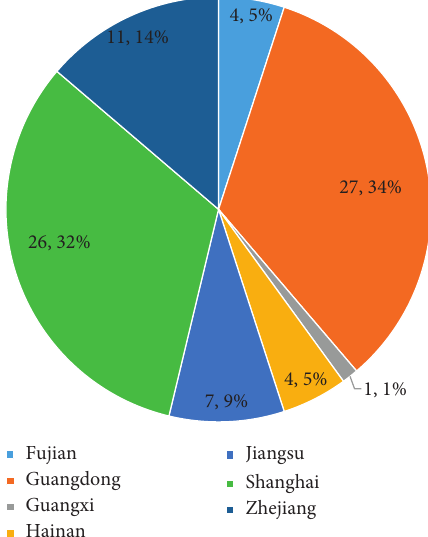
Figure 2: Distribution of listed real estate companies by province in the southeast coastal